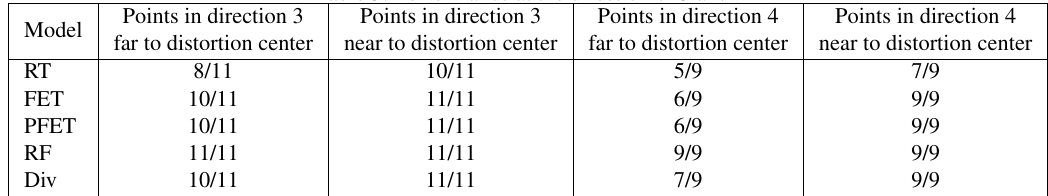
Table 3: Performance at the direction of 3 and 4